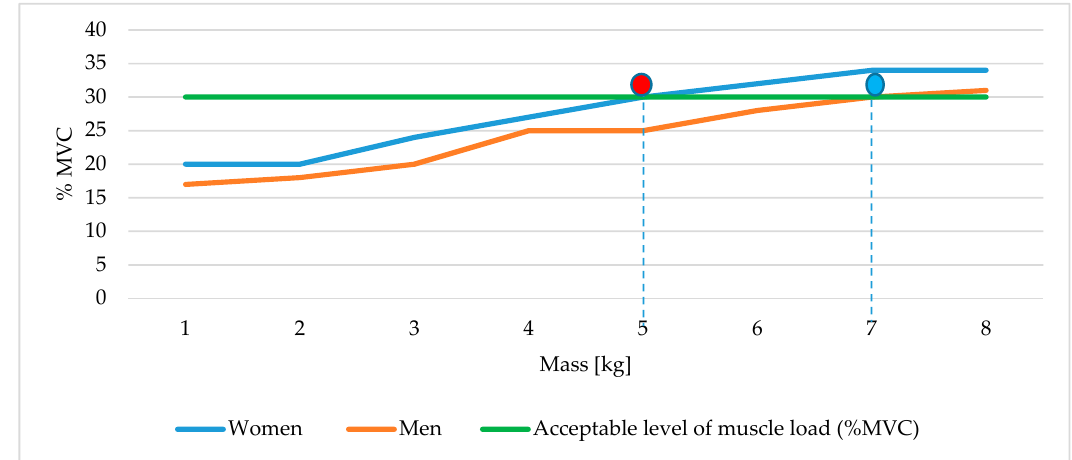
Figure 5. Determination of the maximum mass of the handled shovel used while loading (for Figure 5. women—red point and for men—blue point).